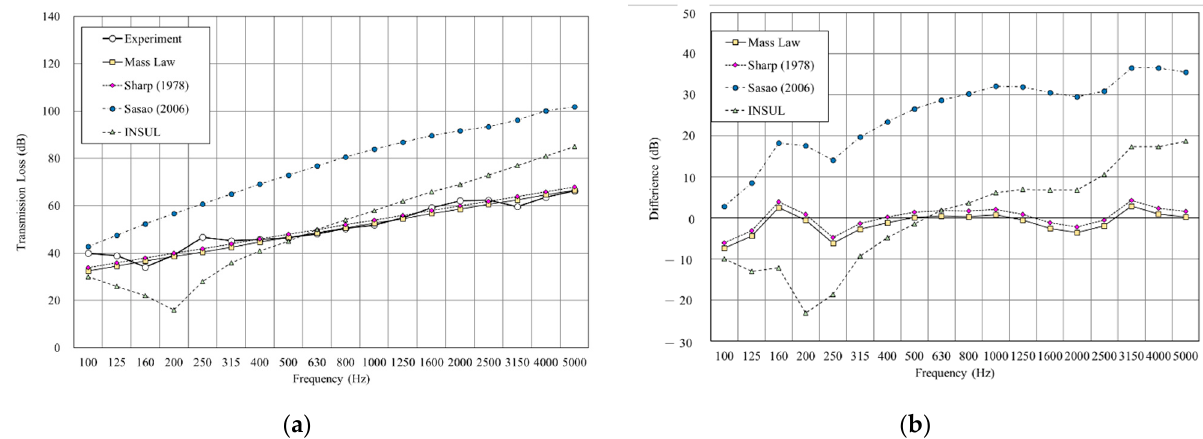
Figure 12. Comparison between experimental and predicted results of the double wall with 25 mm glass wool in 50 mm cavity (B4). ( a ) The sound insulation performance of experiment and prediction. ( b ) The RMSE results of different prediction models.